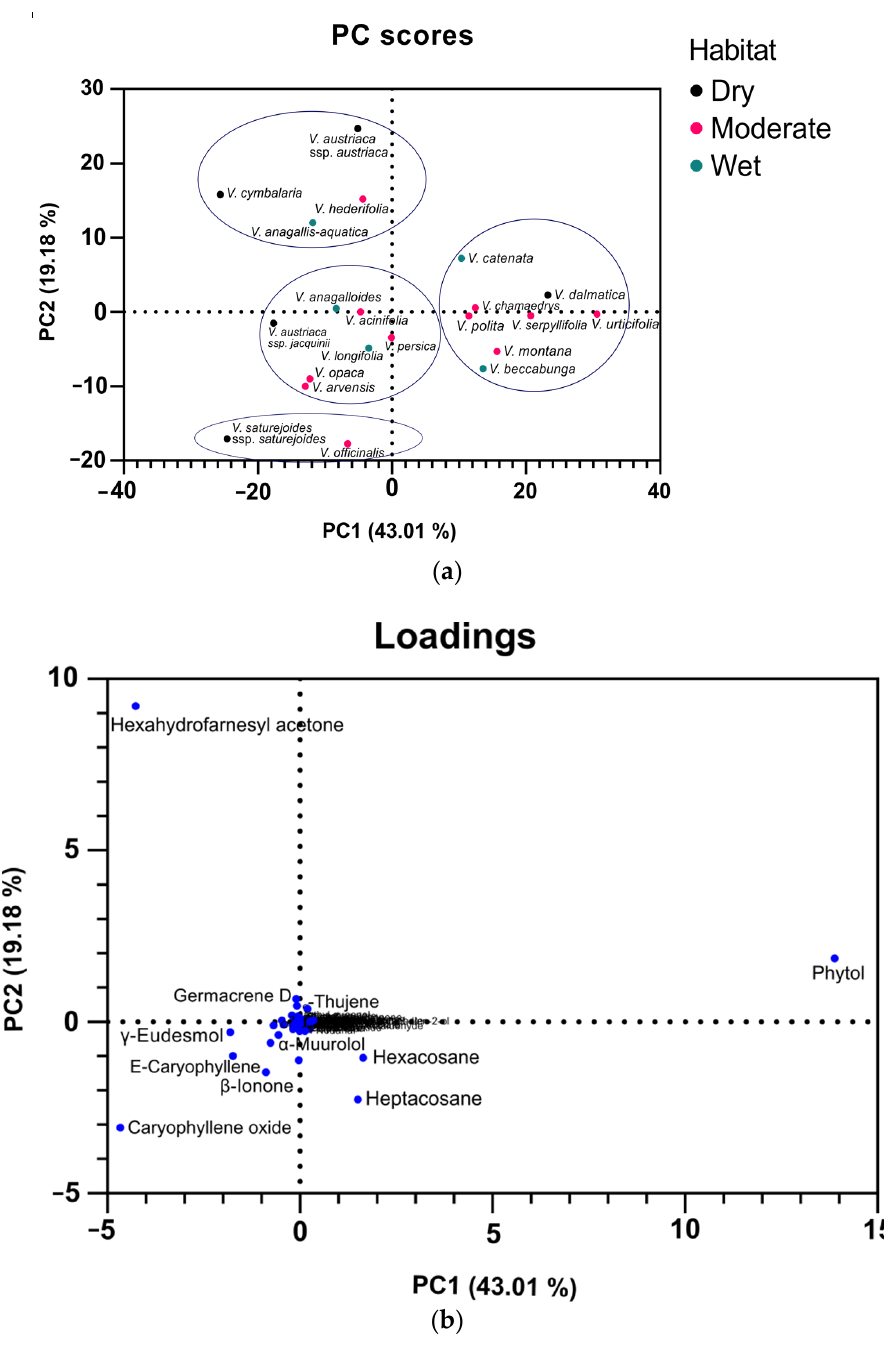
Figure 7. PCA analyses of volatile compounds of 21 Veronica species obtained by hydrodistillation. The PCA score plot allocating different species to clusters ( a ); PCA loading plots of volatiles from the first and second principal components ( b ).